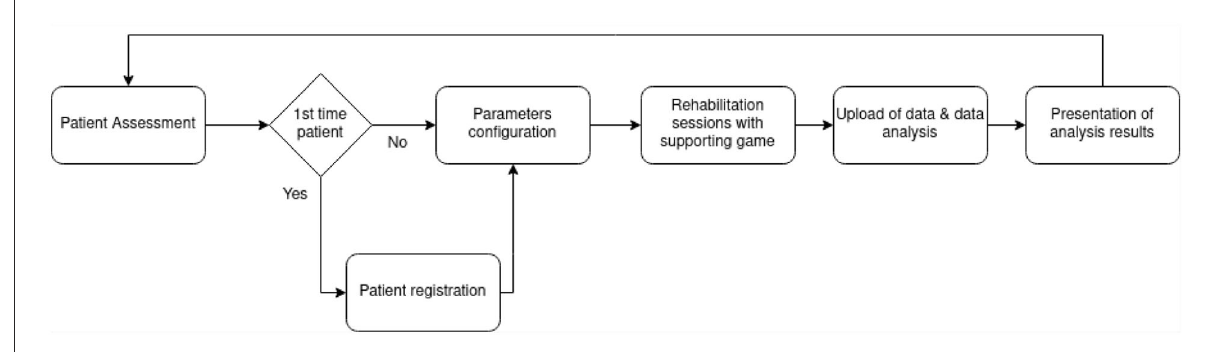
FIGURE1 MILORD design